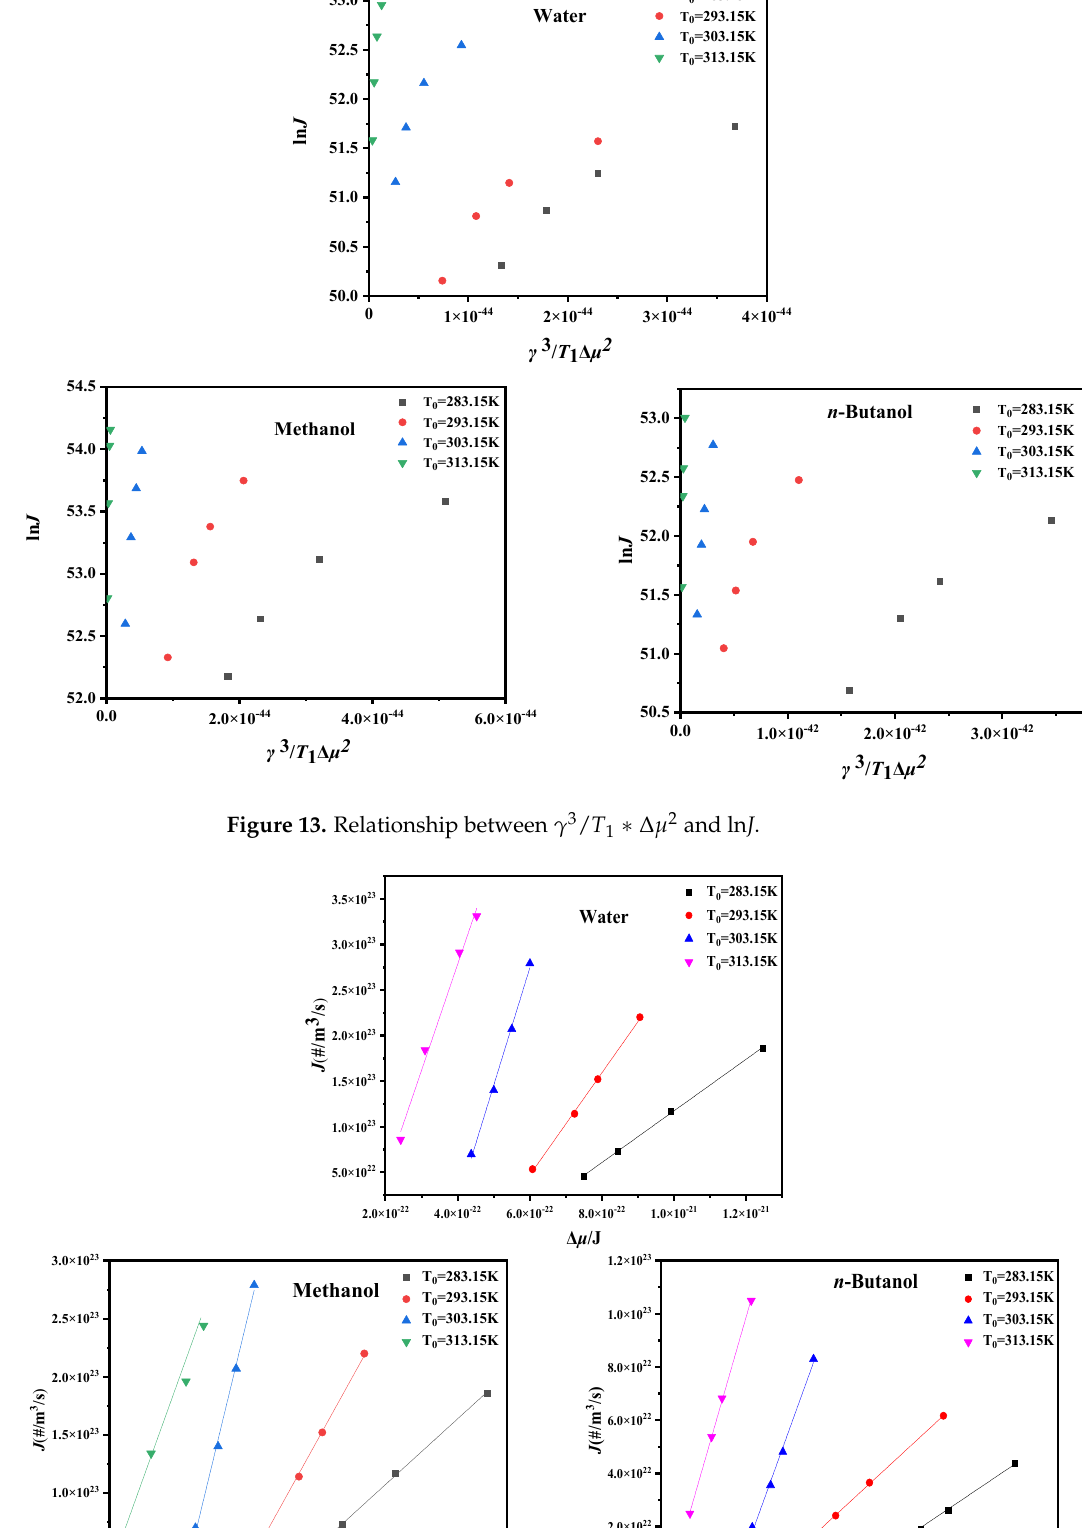
Figure 14. Relationship between the instantaneous driving force and nucleation rate.